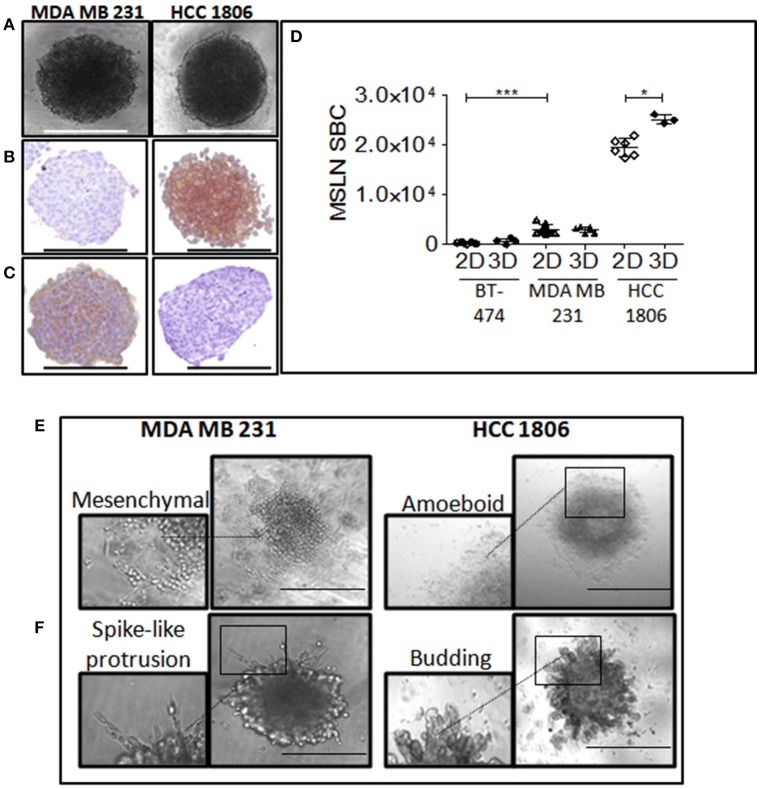
Characterization and phenotypic properties of TNBC spheroids. (A) Representative bright field images of MDA MB 231 and HCC1806 spheroids. (B,C) Epithelial/mesenchymal phenotypes of MDA MB 231 and HCC1806 spheroids. Representative images of E-cadherin (B) and vimentin (C) staining of histological sections of 7 day- spheroids. Scale bar, 500 μm. (D) Specific MSLN binding capacities of 2D and 3D MDA MB 231, HCC1806, and BT474 cell cultures. Values with errors bars represent mean ± SEM (n = 3). Data were analyzed by two-tailed Student's t-test. *P < 0.05, HCC1806 2D vs. 3D models; ***P < 0.001, 2D MDA MB 231 vs. BT474. (E,F) Migration/invasion patterns of MDA MB 231 and HCC1806 spheroids. Representative images of migration (E) and invasion (F) pattern of 4 days spheroids were transferred on 1% gelatin or embedded in 50% matrigel, respectively, and cultured for 2 days at 37°C before imaging. Images were acquired with an EVOS FL Auto microscope. Scale bar, 500 μm.